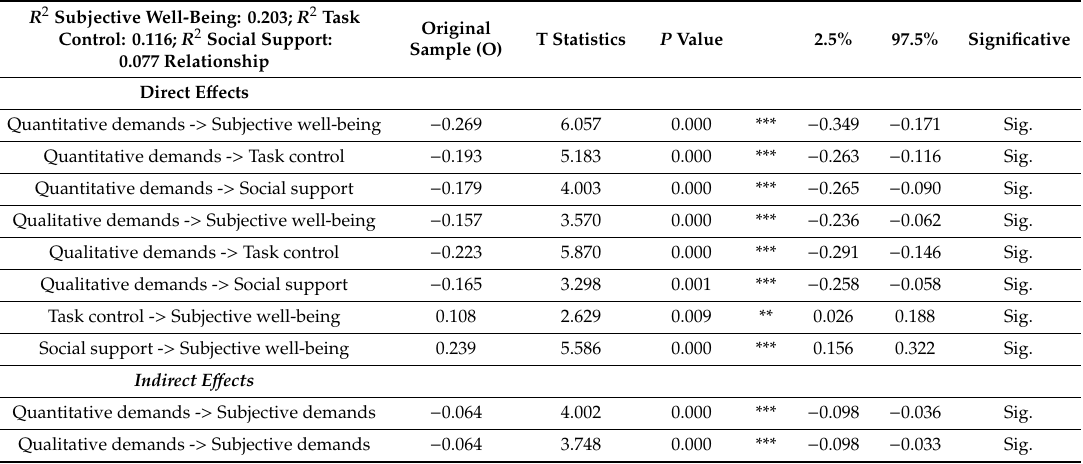
Table 4. Structural Model 2 (Mediating e ff